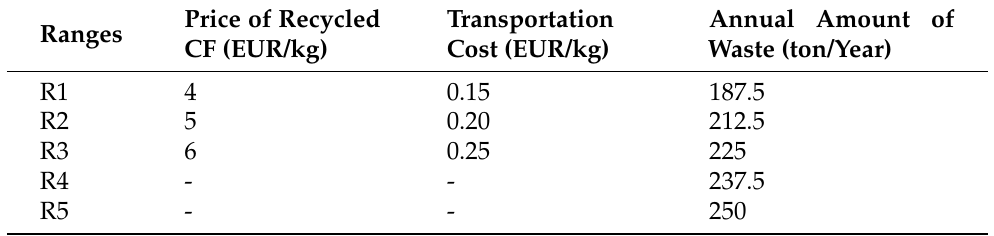
Table 15. Parameters used for sensitivity analysis of the thermal recycling business of a